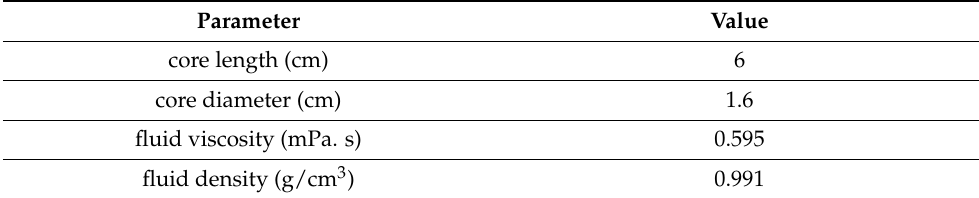
Table 2. Experimental program setting related